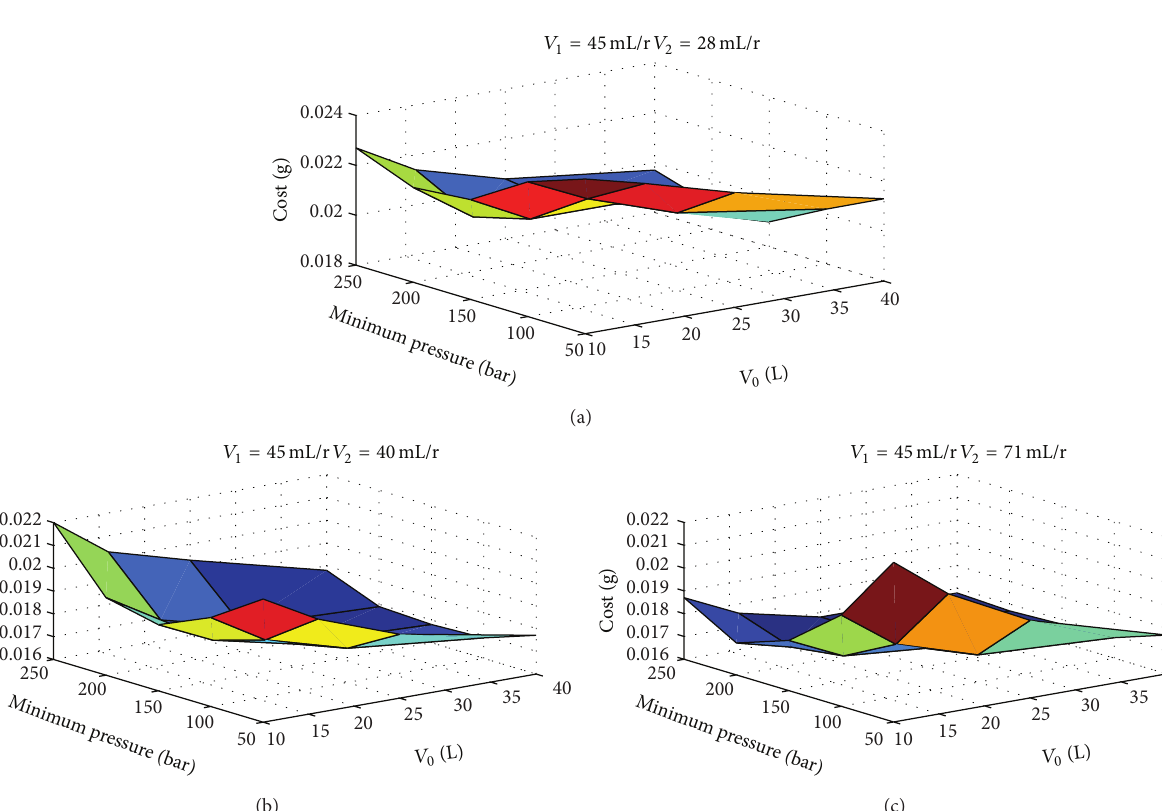
Figure 8: Fuel consumption with the changing accumulator volume and precharge